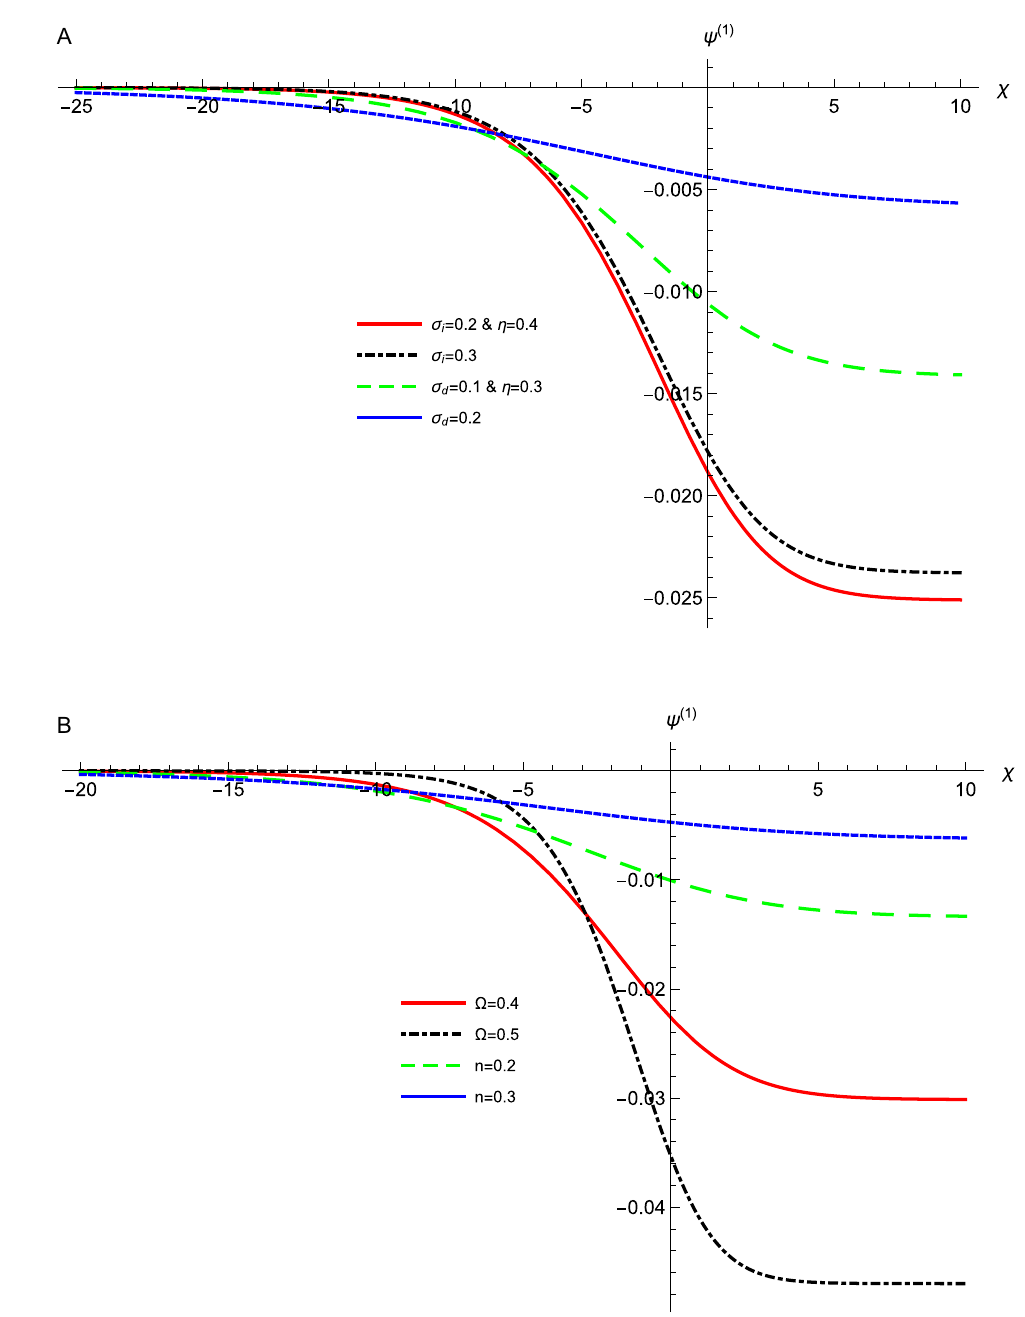
1 ) Figure 3. The evolution of the potential φ ( of the DA waves that represented by Eq. (11) with χ at µ e = 18 , for different values of ( a ) σ i , σ d , and η with n = 0.3 , and (cid:31) = 0.4 , ( b ) n , and (cid:31) = with σ i = 0.2 , σ d = 0.1 , and η = 0.3